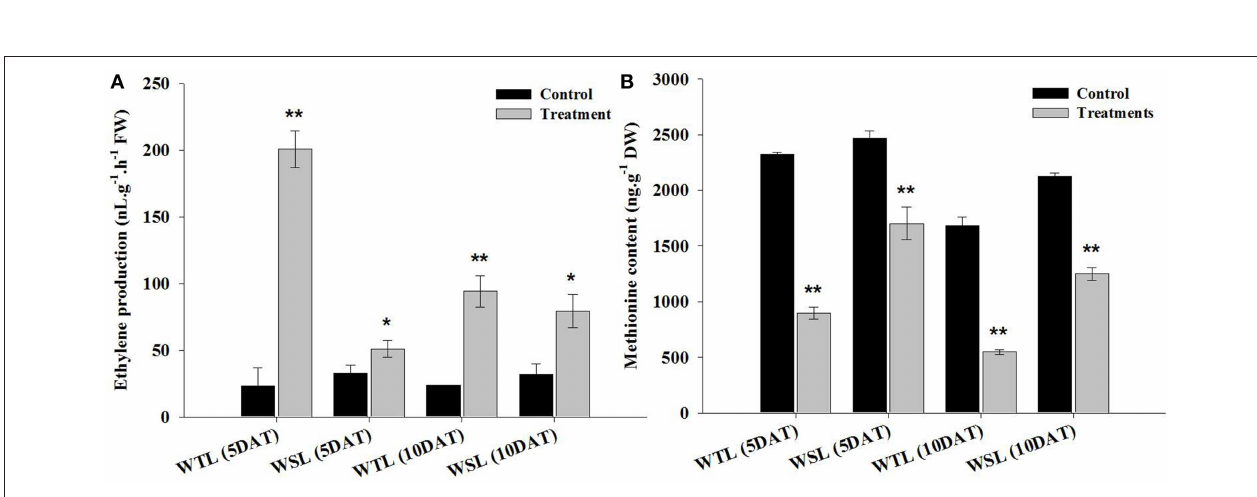
FIGURE 2 | Ethylene production (A) and amino acid content (B) in two soybean lines (WTL and WSL) after 5 and 10 days of waterlogging treatment. In the figure, WTL denotes the waterlogging tolerant line (PI408105A) and WSL denotes the waterlogging susceptible line (S99-2281). Data is the average ± standard error ( n = 3 ). The * and ** shows the values are significantly different using P < 0.05 and P < 0.01